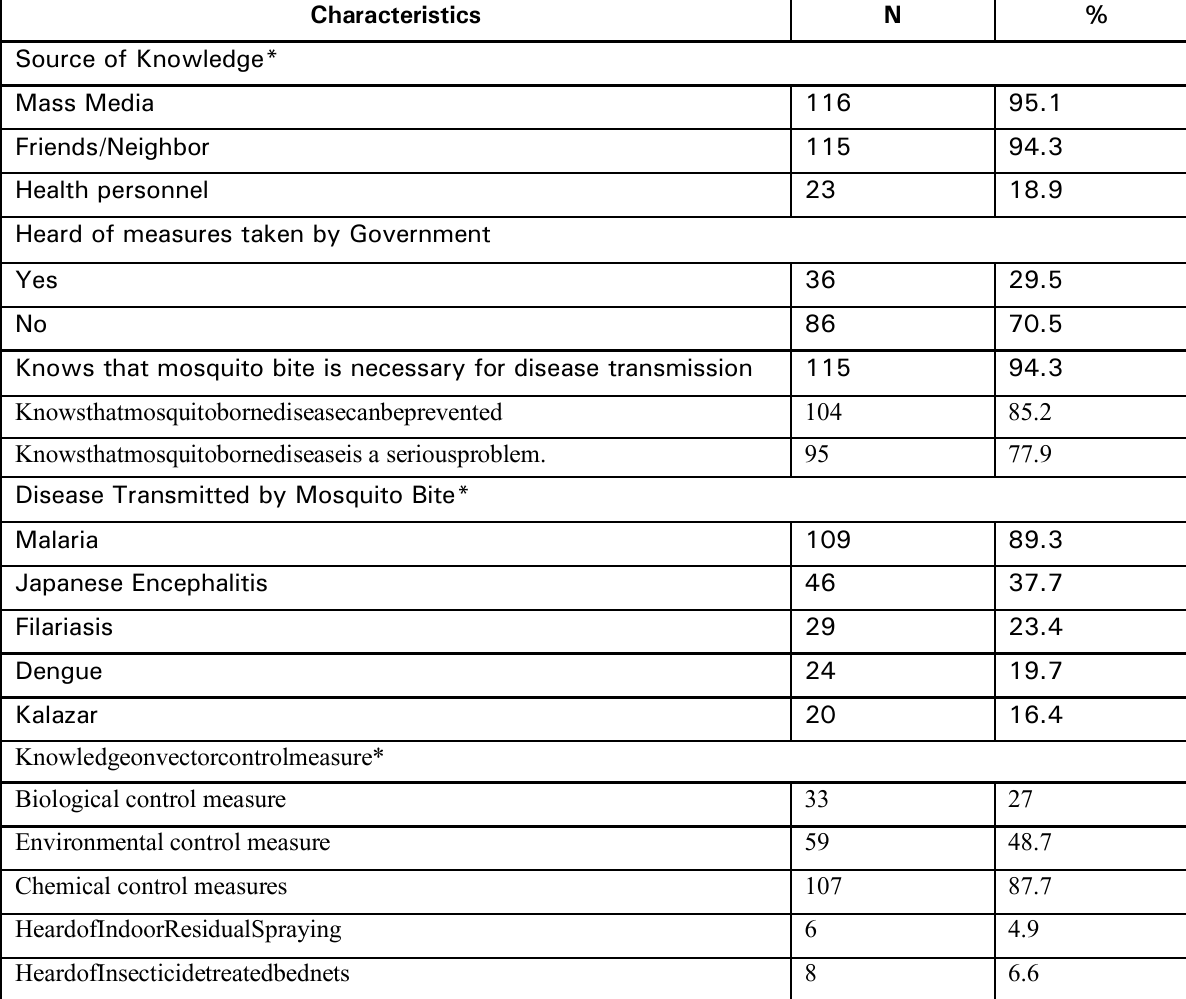
Table 2. Knowledge on mosquito borne diseases